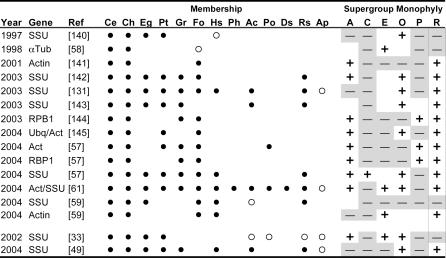
Support for Membership and Supergroup Monophyly from “Rhizaria”-Targeted Molecular GenealogiesMember taxa: Ce, Cercomonadida; Ch, Chlorarachniophyta; Eg, euglyphids; Pt, Phytomyxea (plasmophorids); Ph, Phaeodarea; Gr, Gromia; Fo, Foraminifera; Hs, Haplosporidia (Ascetosporea); Po, Polycystinea; Ac, Acantharia; Ds, desmothoracids; Rs, residua; Ap, apusomonads. The position of apusomonads, Ap, was not considered when scoring the monophyly of “Rhizaria” as the position of this organism is highly variable, and it has been removed from recent classifications (see text). See Figure 4 for further notes. References cited in this figure are [33,49,57–59,61,131,140–145].